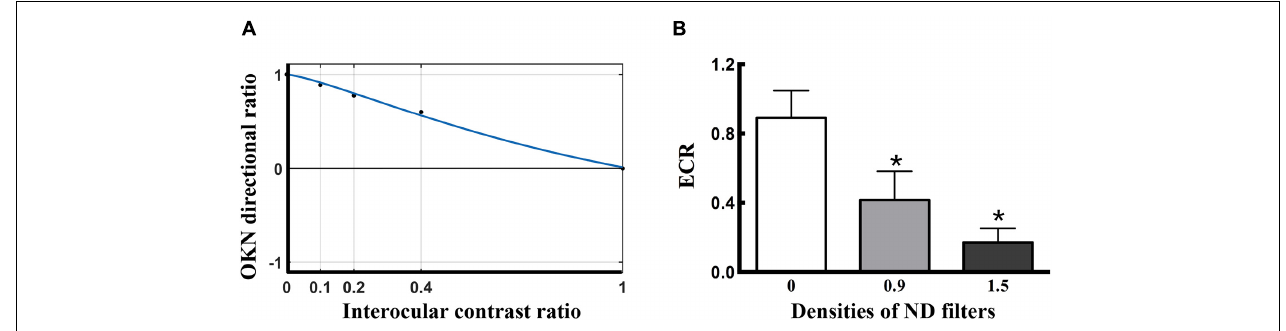
FIGURE 2 | Visual suppression measured by dOKN test in control subjects. (A) The fitting curve of a healthy control. The x -axis represents the grating contrast ratio (dominant/non-dominant), and the y -axis represents the OKN directional ratio. In normal subjects, the suppression depth monotonically decreased with increasing stimuli contrast to the fellow eyes. The ECR is defined as the contrast ratio of the interocular balance points, which is the corresponding value of the x -axis when y = 0 that both eyes dominate in a balanced manner. (B) The ND filter induced visual suppression in the healthy controls. *Represented statistical difference.